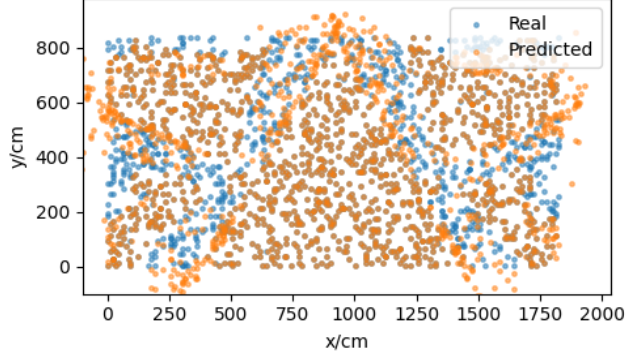
Figure 10. Part of the virtual data generated by the vector positioning error model.